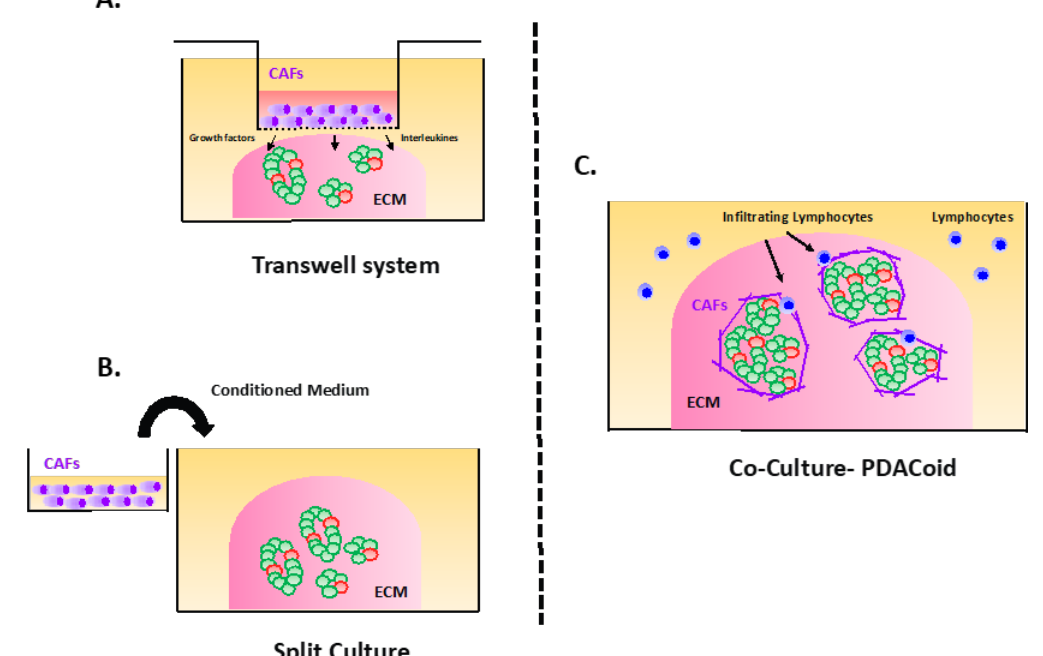
Figure 2. Pancreatic ductal adenocarcinoma (PDAC) organoids co-culture with cancer-associated fibroblasts (CAFS) and immune cells: “the PDACoids”. ( A ) Using conditioned medium, ( B ) using Transwell ® system, and ( C ) “ three-dimensional PDACoids ”.